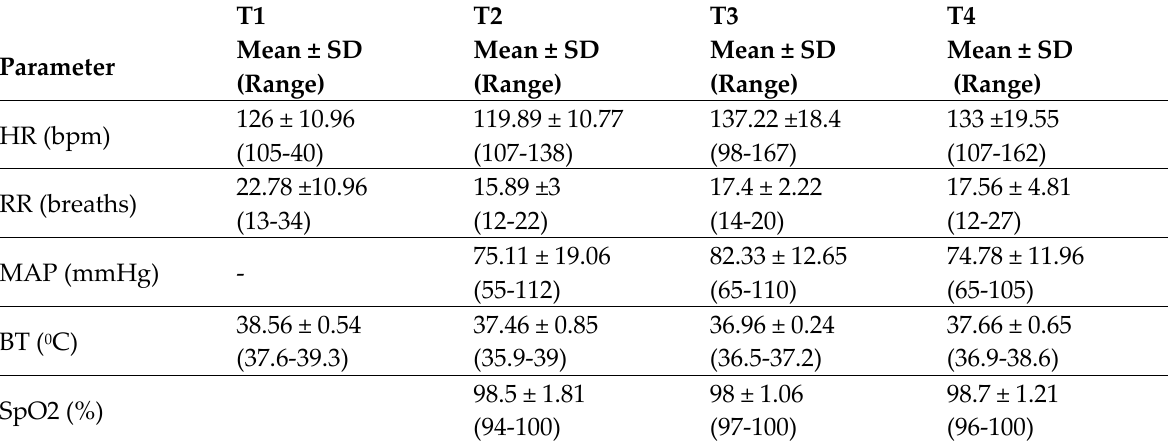
Table 1. Values of physiologic parameters in cats during laparoscopy